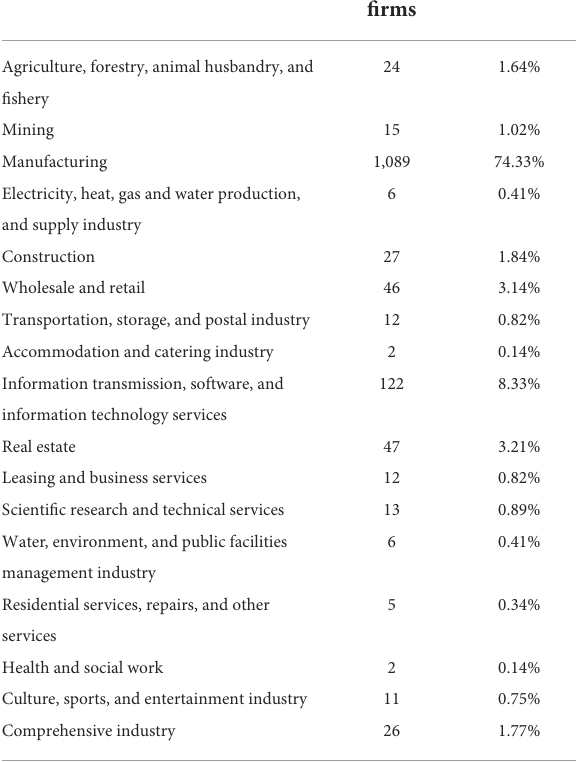
TABLE 1 Industry distribution of sample